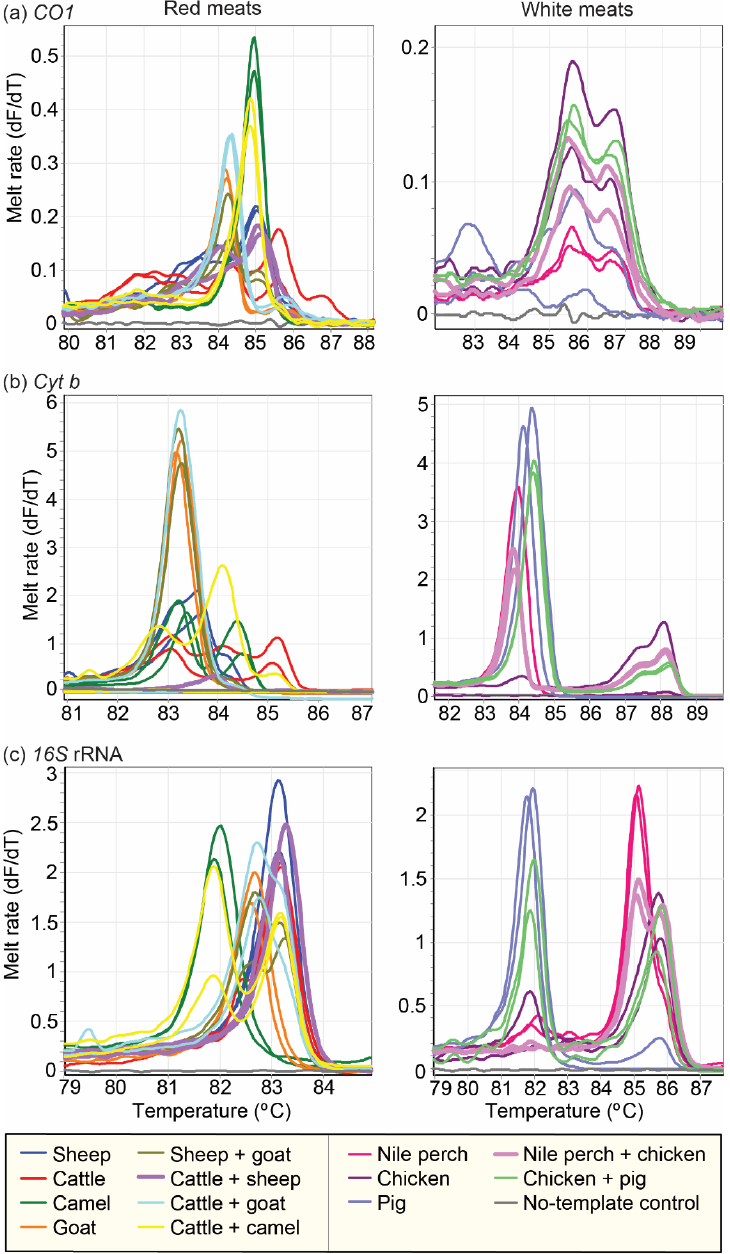
Figure 6. PCR-HRM melt rate profiles of pure and mixed meat samples assessed using three mitochondrial markers. The left column represents red meat sources (sheep, goat, cattle, and camel) and their corresponding mixtures, whereas the right column represents DNA from white meat sources (Nile perch, chicken, and pig) and their mixtures. Distinct melt rates are represented as changes in fluorescence units with increasing temperatures (dF/dT) for ( a ) CO1 , ( b ) cyt b , and ( c ) 16S rRNA markers.